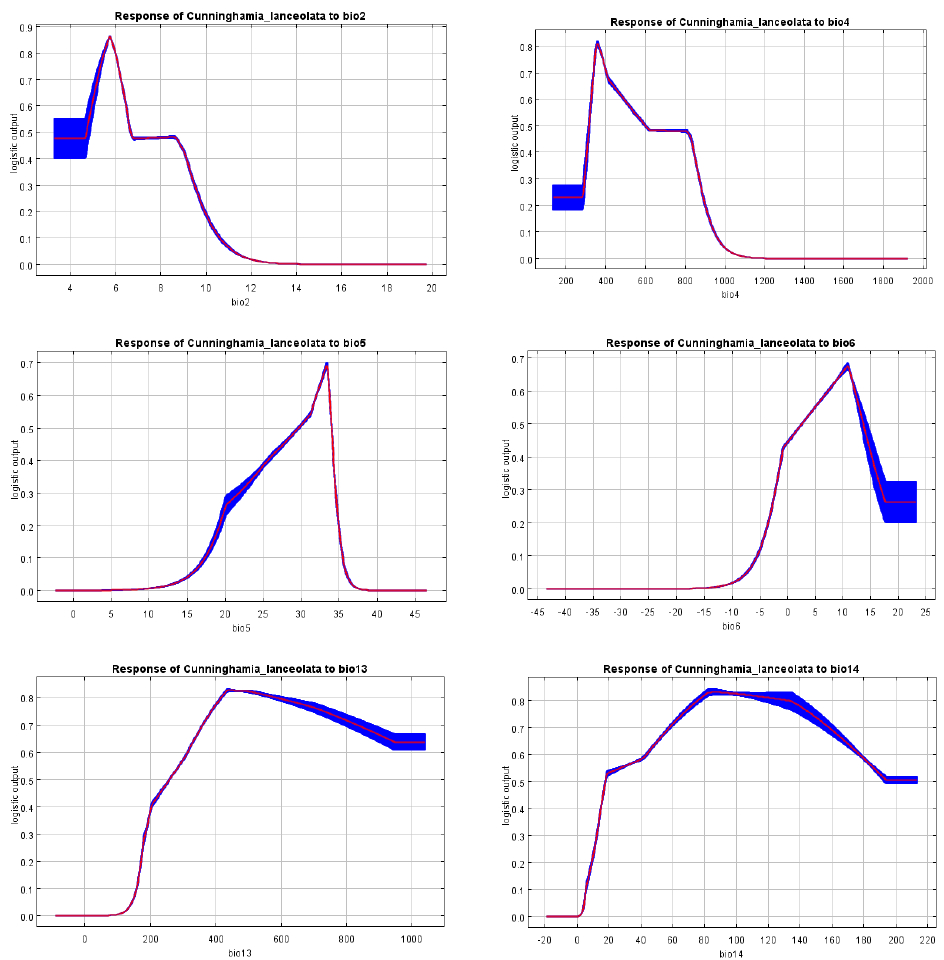
Figure 4. Response curves for the probability of presence for C. lanceolata. The red curves show the average over 10 replicate runs; blue bands show the standard deviation (SD) calculated over 10 replicates.